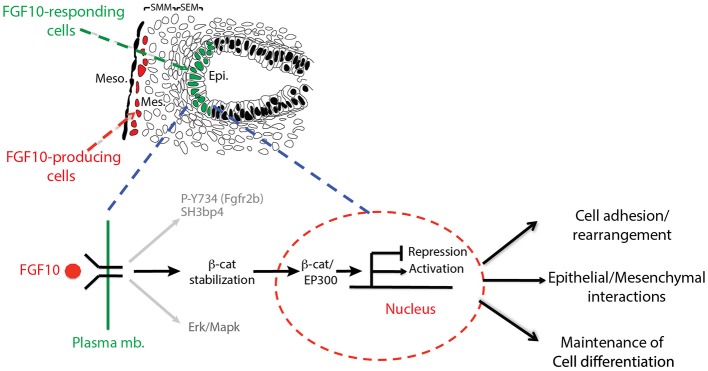
Graphical summary: FGF10 signaling leads to phosphorylation of Y734 on FGFR2 associated with Sh3bp4 recruitment (Francavilla et al., 2013). FGF10 signaling also induces Erk/Mapk phosphorylation and stabilizes ß-catenin, promoting its translocation to the nucleus where it binds to EP300, acting as a transcriptional regulator. The resulting activated (FGF10 transcriptomic signature) and/or repressed genes in turn control cell adhesion/rearrangement, contribute to epithelial/mesenchymal interactions, and maintain distal tip differentiation.